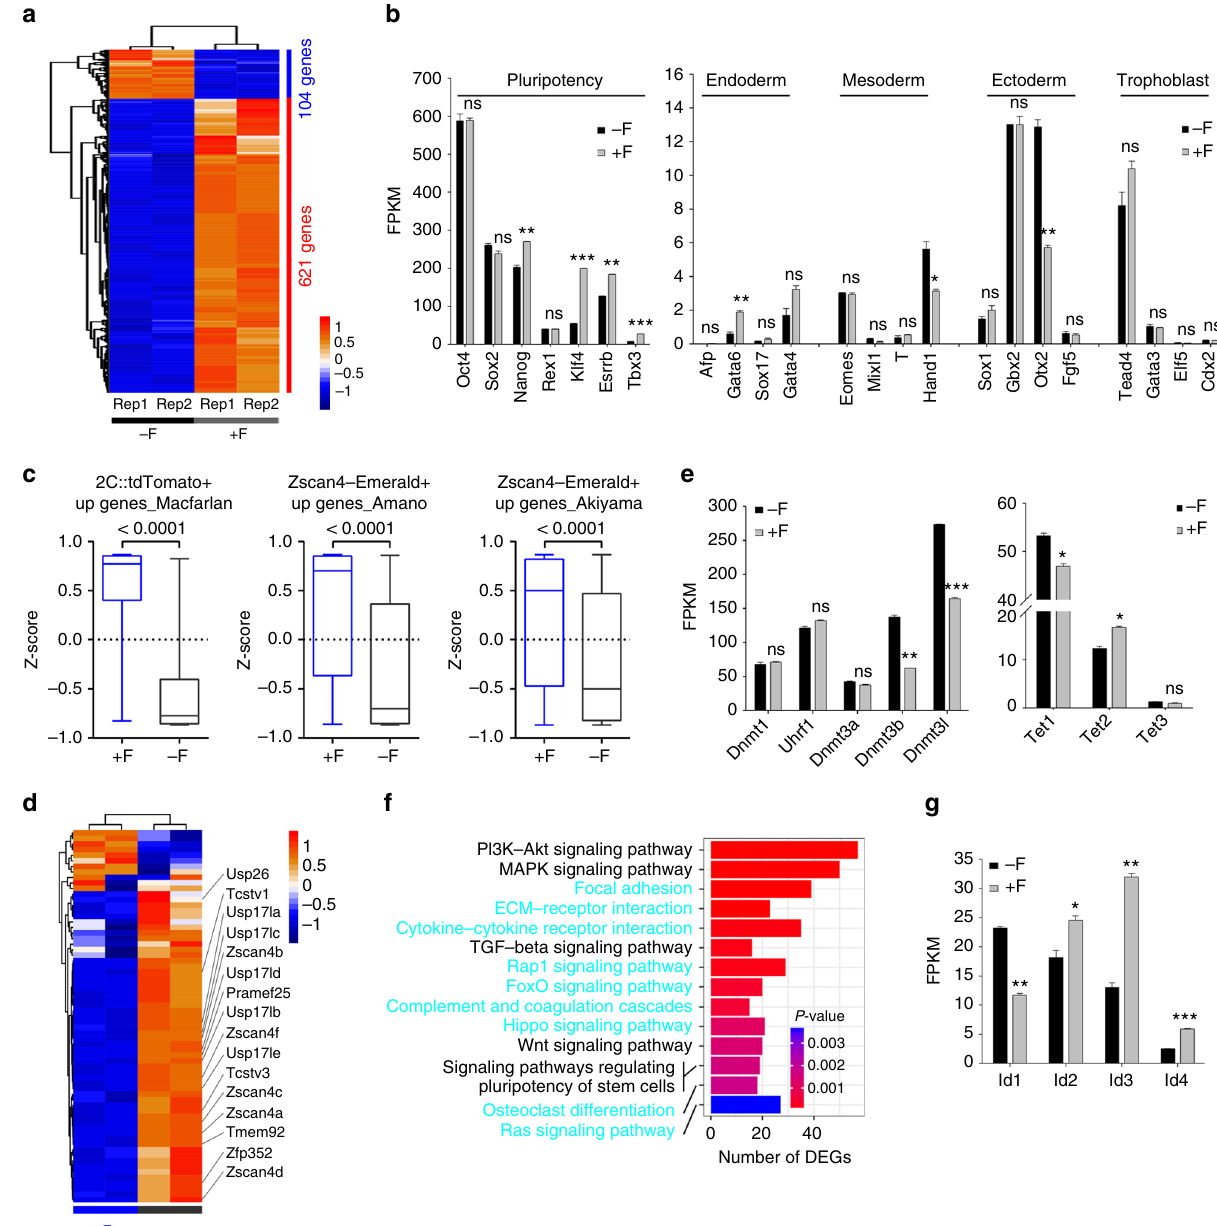
Fig. 4 Transcriptome and signal pathways by RNA-seq analysis. a Heatmap illustrating differentially expressed genes (DEGs) between N33 ESCs cultured without ( − F) and with feeders ( + F). Two biological replicates were analyzed per group. Genes with ≥ 2-fold expression changes, P adj < 0.05 were chosen for heatmap. b Expression levels (FPKMs) of pluripotency and lineage marker genes in − F and + F ESCs. c Z -scores of several gene lists: upregulated genes in 2C::tdTomato + ESCs from Macfarlan et al. 10 , Zscan4-Emerald + ESCs from Amano et al. 31 , or in Zscan4-Emerald + ESCs from Akiyama et al. 32 . d Heatmap shows expression of representative 2C genes in − F and + F ESCs. e Expression levels (FPKMs) of multiple genes involved in DNA (de) methylation. f The enriched KEGG pathways of DEGs between − F and + F ESCs. g Expression levels (FPKMs) of BMP-Smad targeting Id genes. * P < 0.05, ** P < 0.01, *** P < 0.001, ns not signi fi cant ( P > 0.05). Student ’ s t